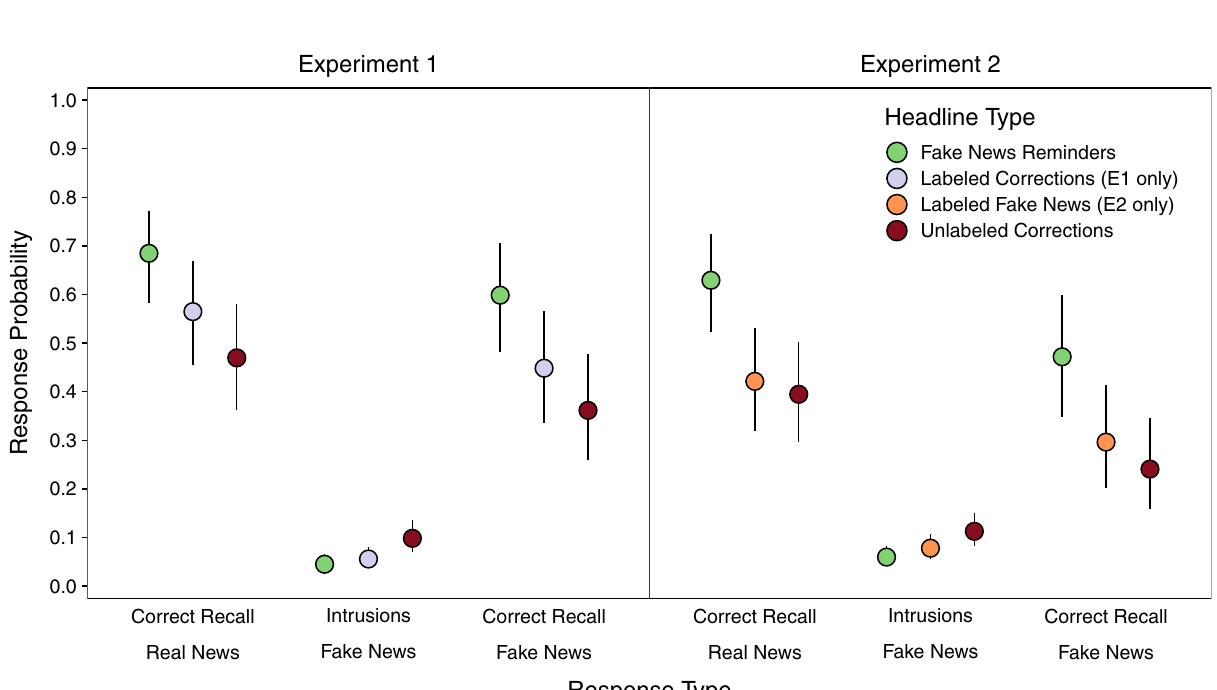
Table 1. Model results for real news recall, intrusions of fake news, and fake news recall in Phase 3. The results above correspond to the data visualized in Fig. 2 (for overall recall) and Fig. 3 (for conditional recall).